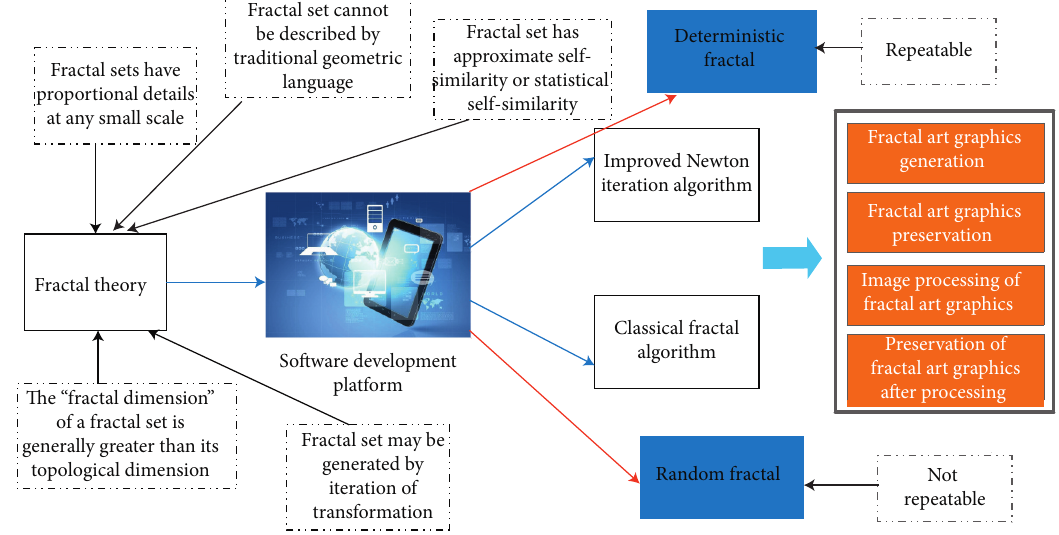
Figure 1: Framework diagram of fractal graphic design